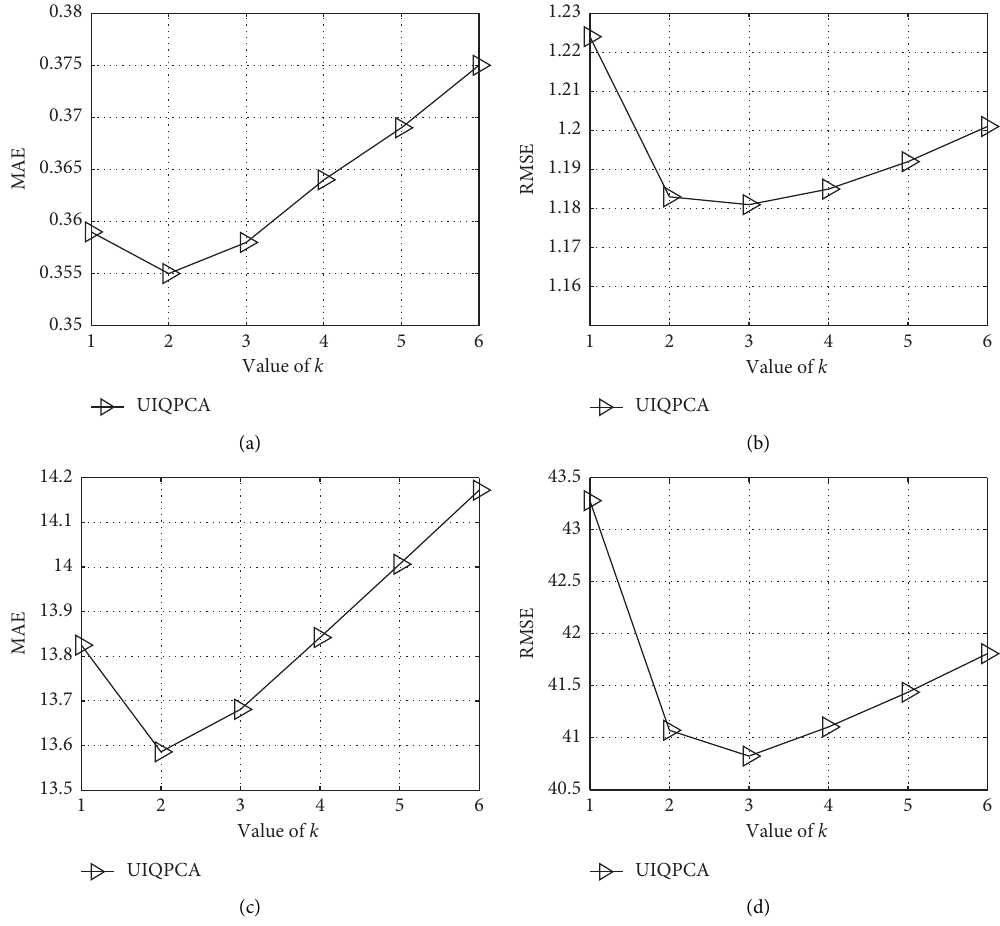
Figure 6: Impact of k on UIQPCA with the WS-Dream dataset: (a, b) response time; (c, d) throughput. (a) MAE vs. k , (b) RMSE vs. k , (c) MAE vs. k , (d) RMSE vs. k